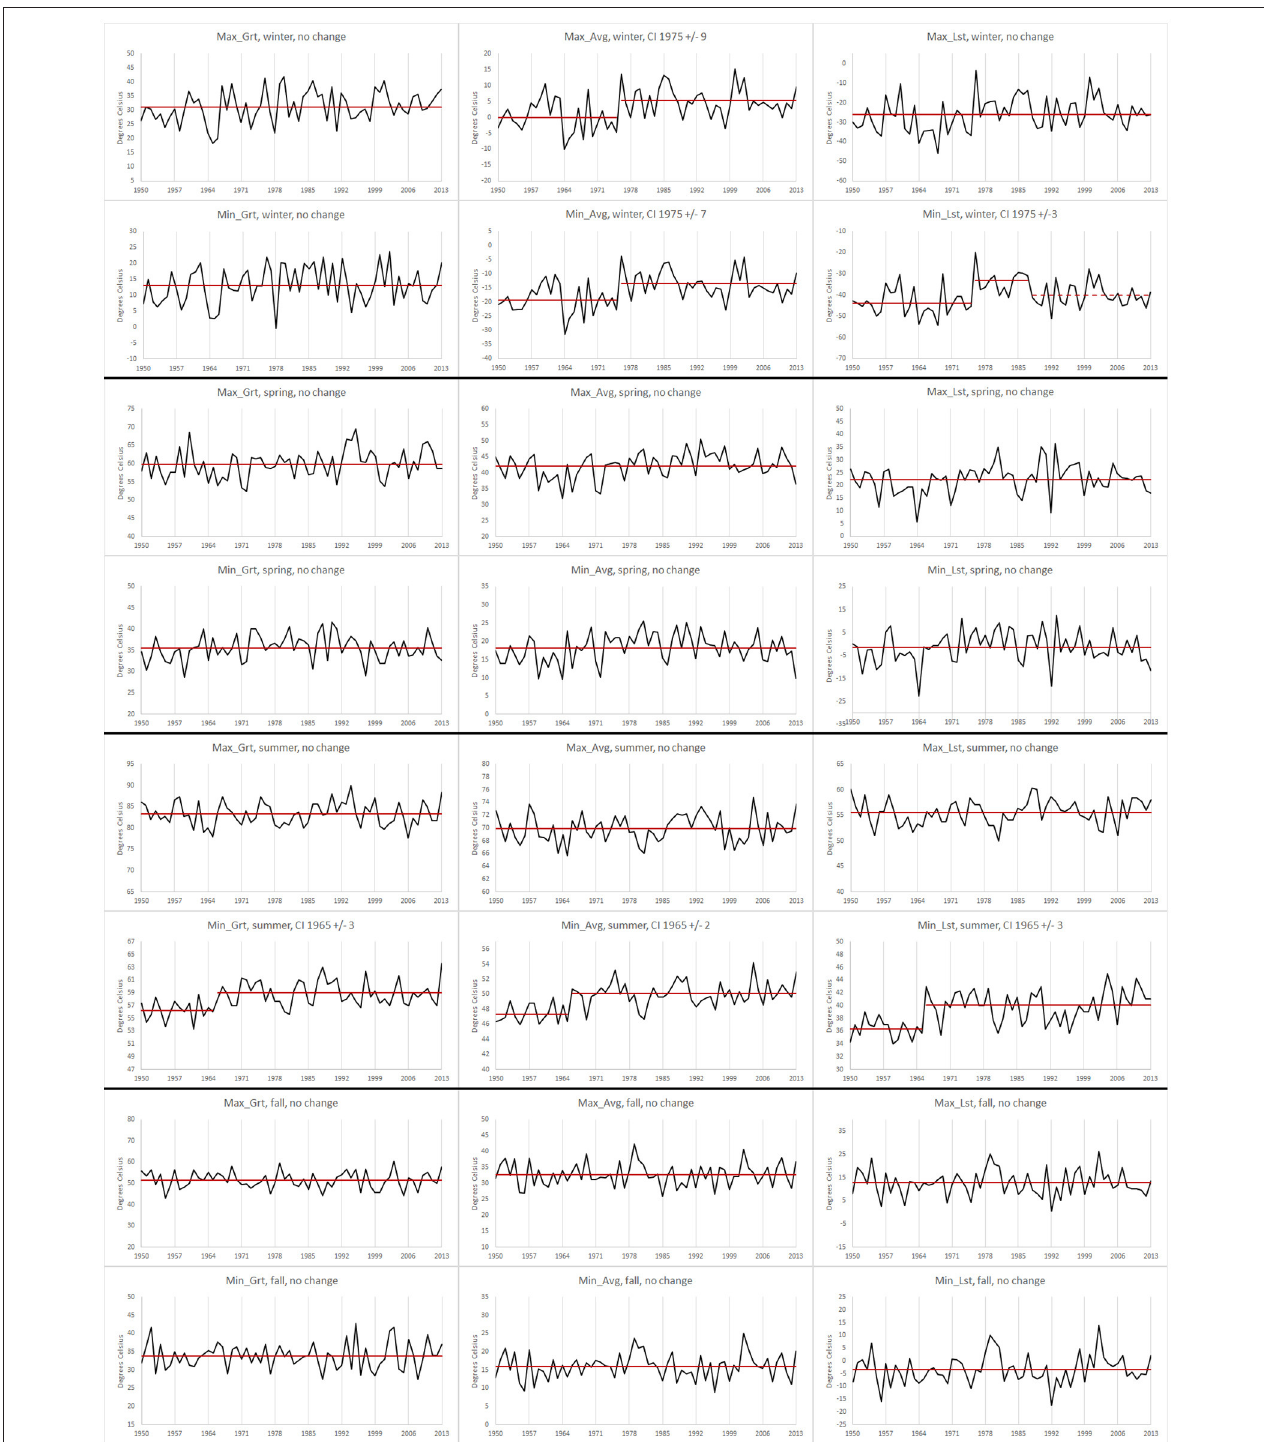
FIGURE 4 | FIA temperature data series for the time-period 1950–2013 for variables Max_Grt, Min_Grt, Max_Avg, Min_Avg, Max_Lst, and Min_Lst for winter ( A : Rows 1–2), spring ( B : Rows 3–4), summer ( C : Rows 5–6), and fall ( D : Rows 7–8) together with data means within each segment, where each segment is determined by change-point analysis; solid red lines represent data means within each segment with shifts identified by both the PELT method and the change detection test statistic; dashed red lines indicate data means for segments identified by PELT method but not confirmed by the change detection static when at least one other change is detected by both